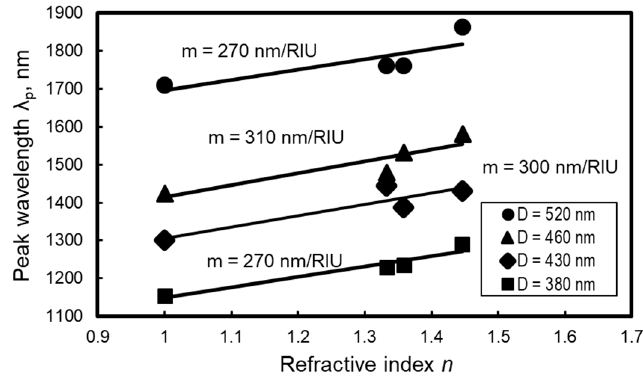
Figure 13. Change in peak wavelength against refractive index.